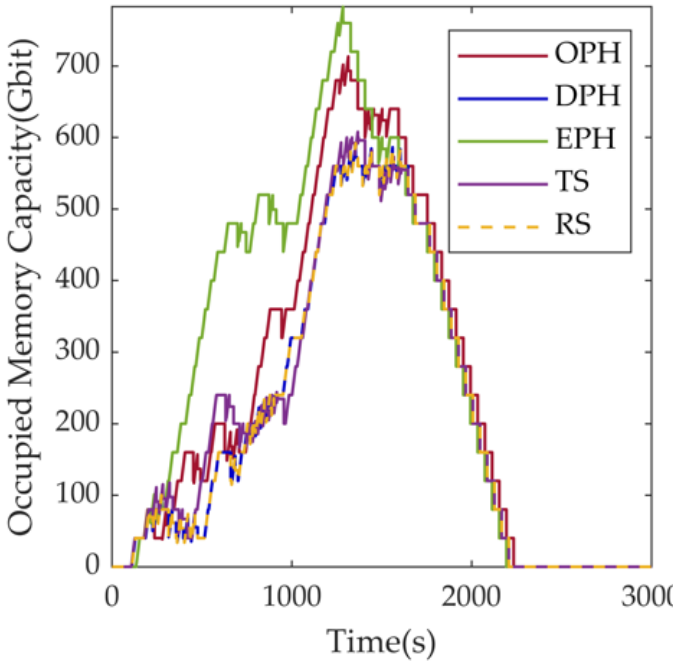
Figure 13. Satellite occupied memory capacity diagram of a single condition in the second group.